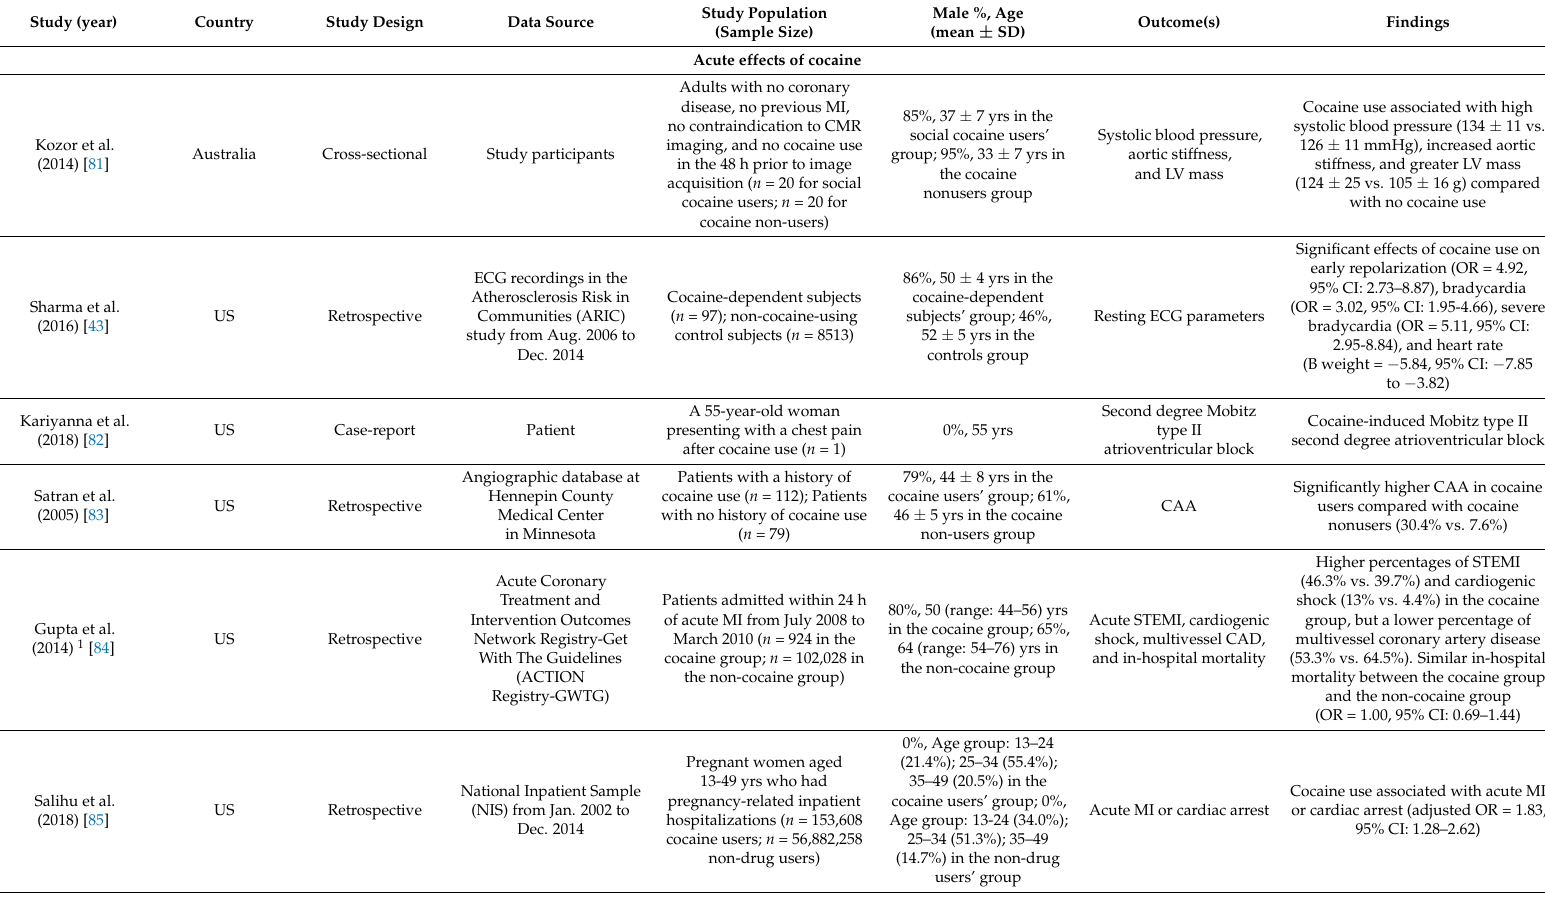
Table 1. Acute and chronic effects of cocaine on the cardiovascular